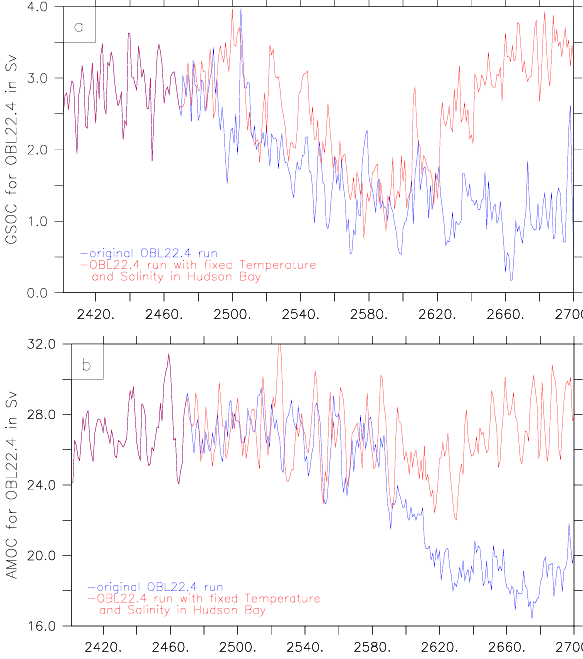
Fig. 6. (a) GSOC for original OBL22.4 run (blue) and (red) a restart of OBL22.4 run in which a temperature and salinity “climatology” in the Hudson Bay was generated from the years 2401 to 2450 and prescribed for 950 model years. (b) Same as in (a) for AMOC. Please refer to Sect. 4.3 for